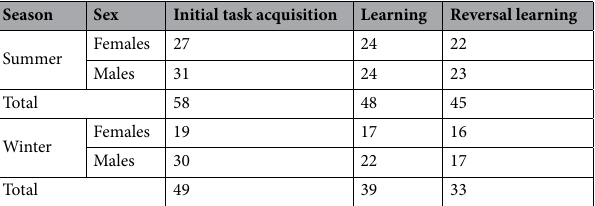
Table 1. Sample size for the initial task acquisition, the learning and reversal learning tasks. Mice who were not trapped within 6 days (due to predation or dispersal) were excluded from